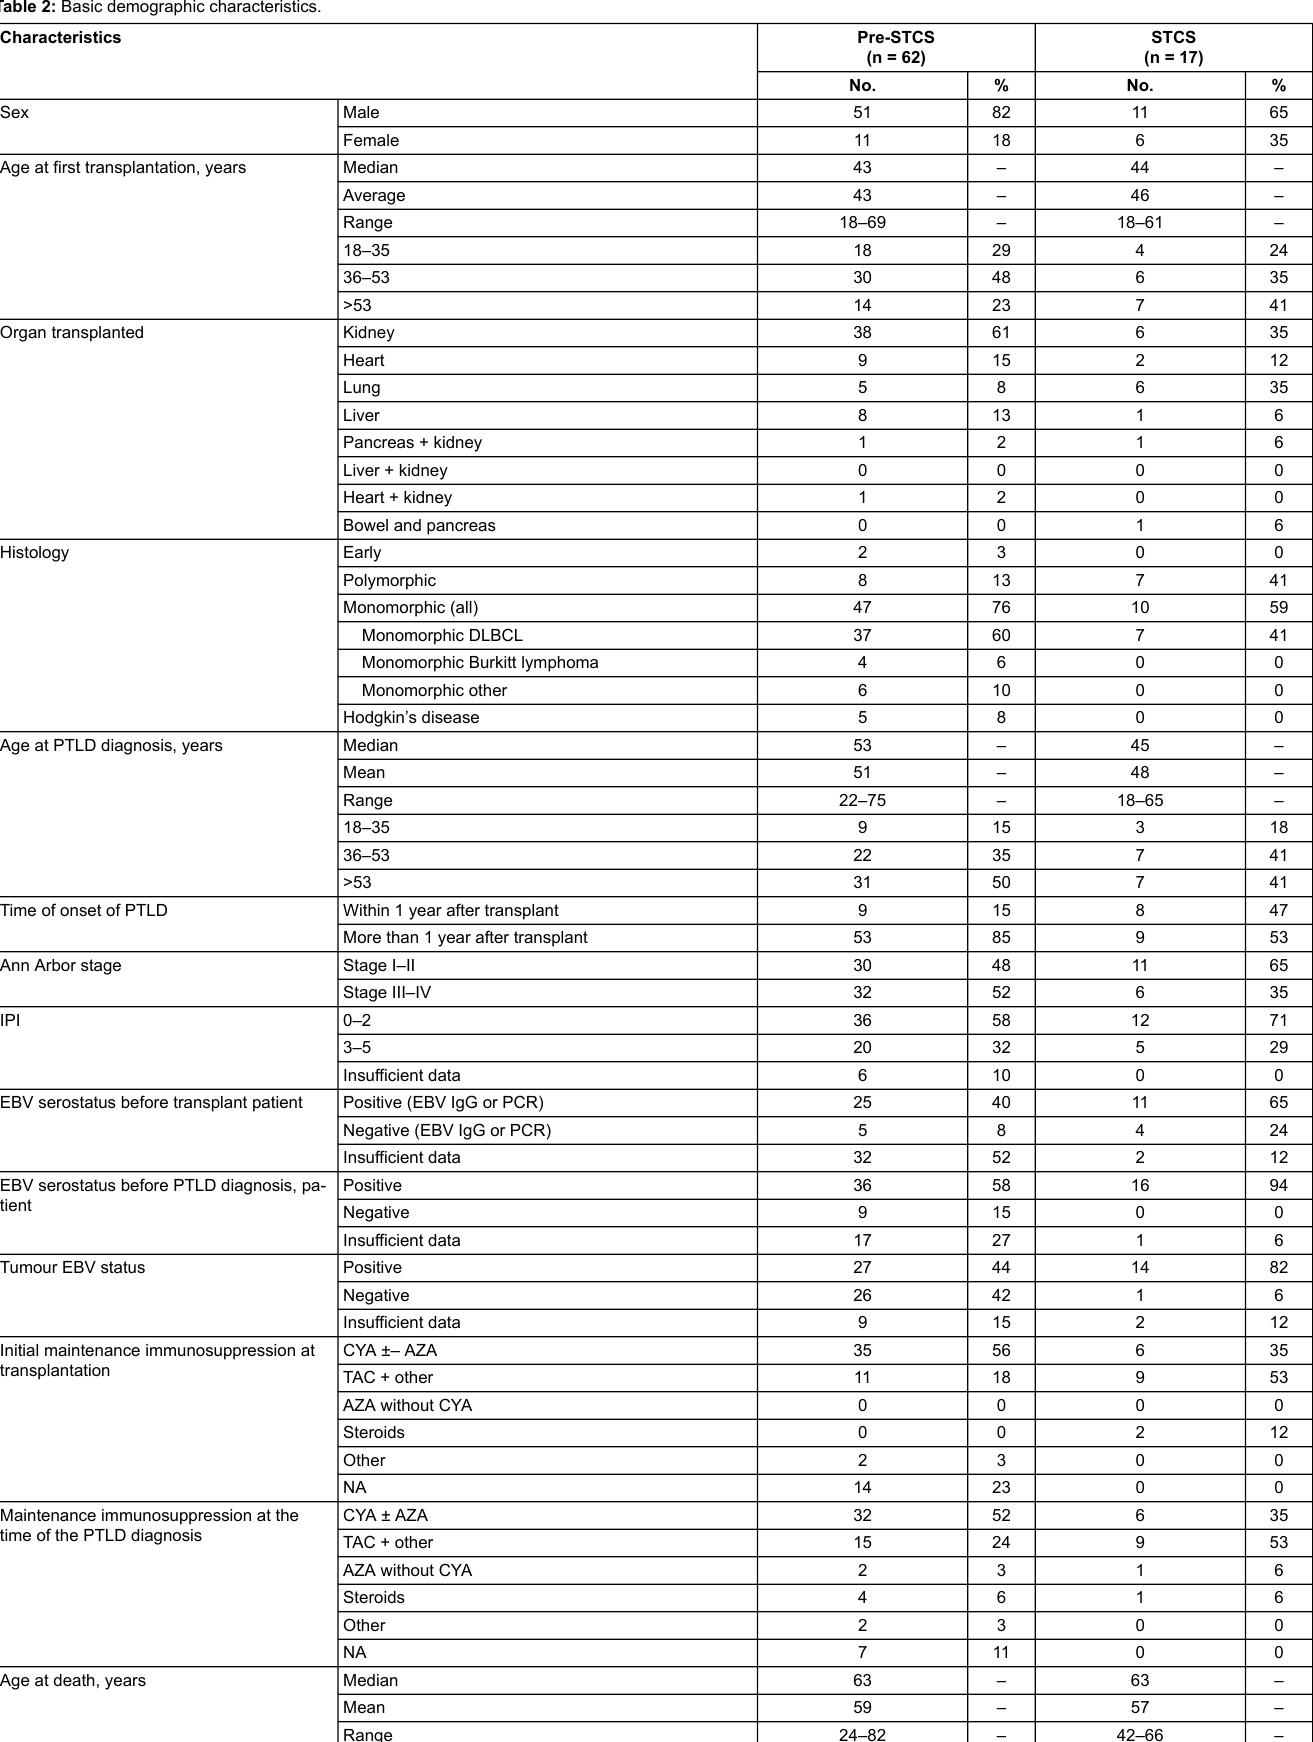
Table 2: Basic demographic